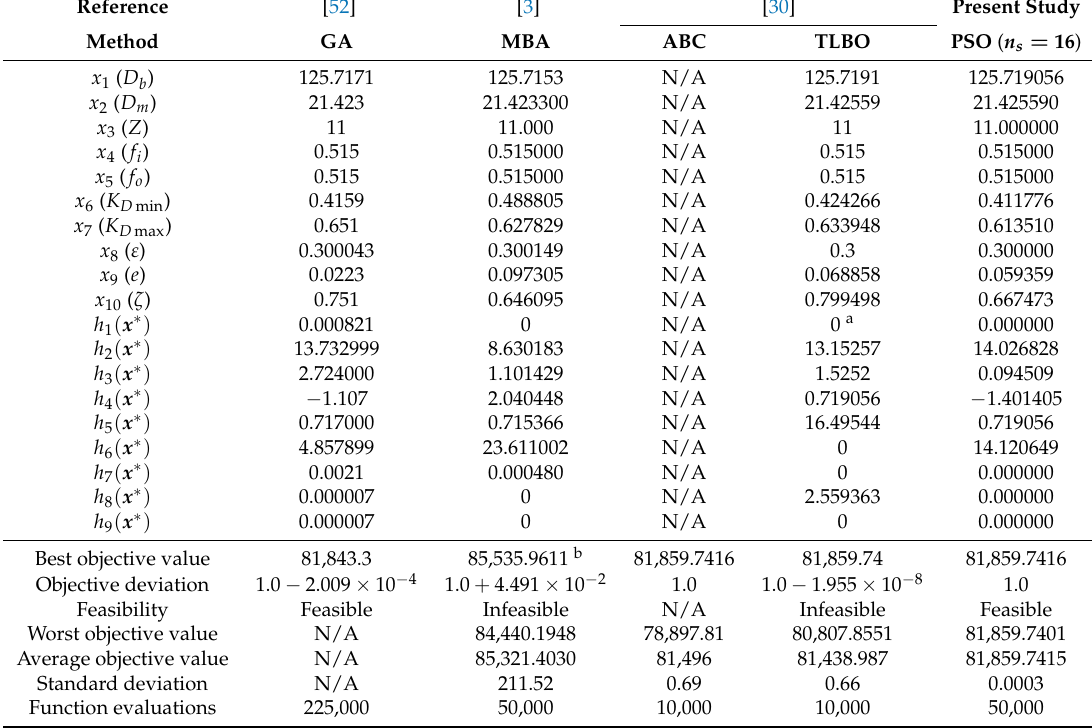
Table 11. Optimization results of the rolling element bearing design